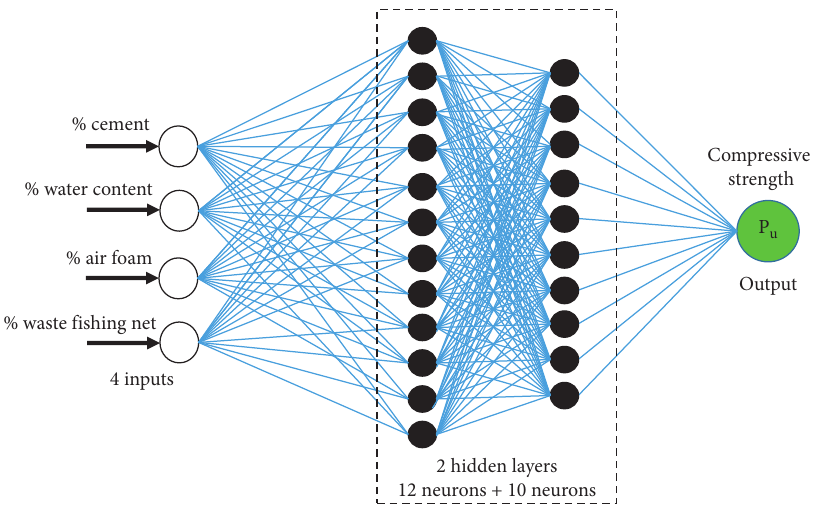
Figure 2: Architecture for the developed ANN: 4 inputs, 2 hidden layers, and 1